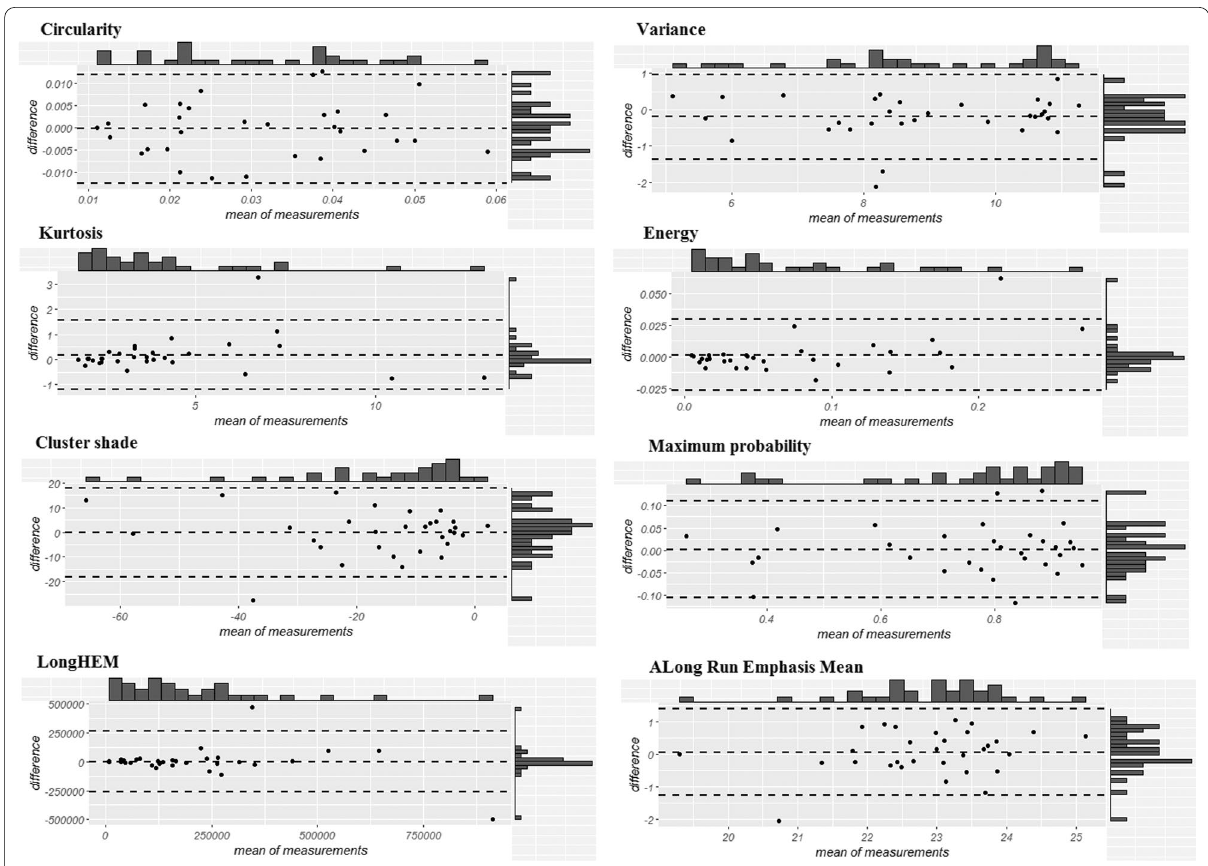
Fig. 4 Reproducibility of eight radiomic features regarding measurements between